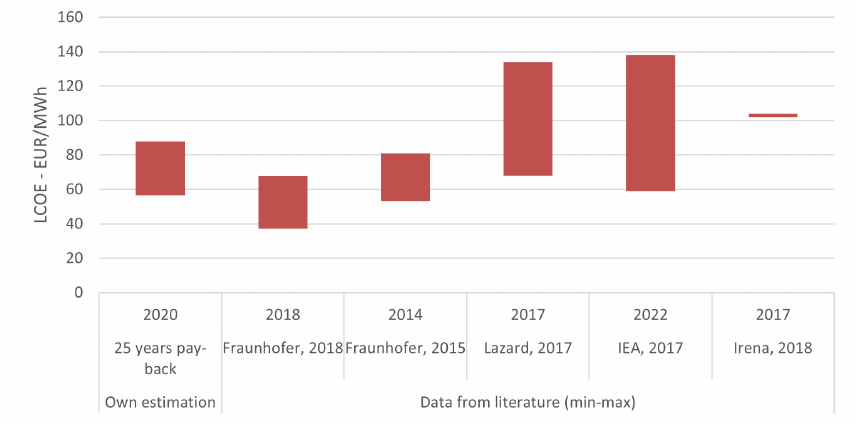
Figure 3. Own LCOE estimation referencing values from the literature, source: Fraunhofer, 2018; Fraunhofer, 2015; Lazard, 2017; IEA, 2017; Irena, 2018; EEMM